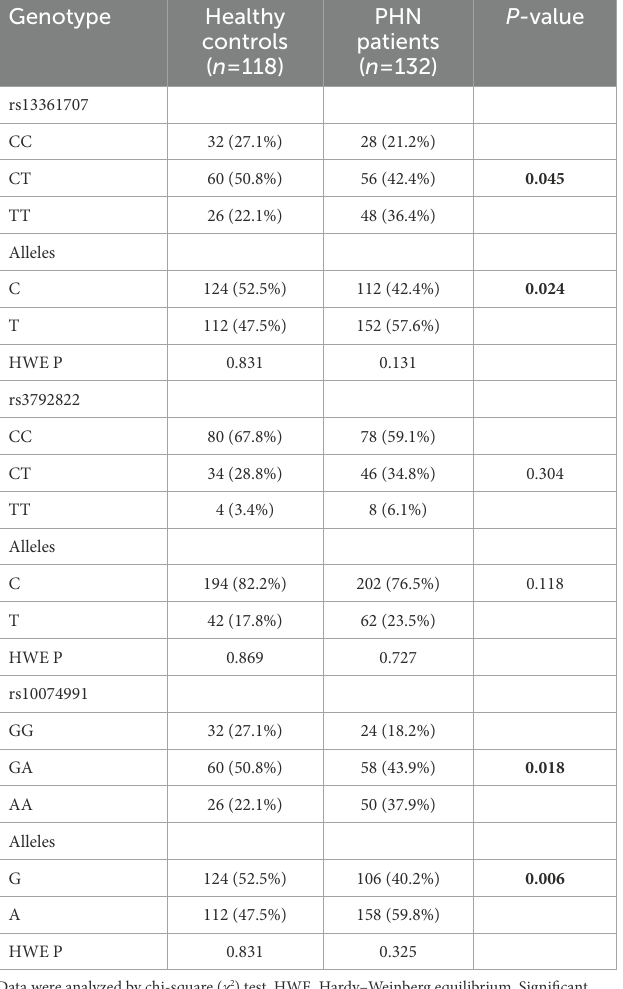
TABLE 2 Comparisons of genotype and allelic frequencies of PRKAA1 polymorphisms in PHN patients and healthy subjects.